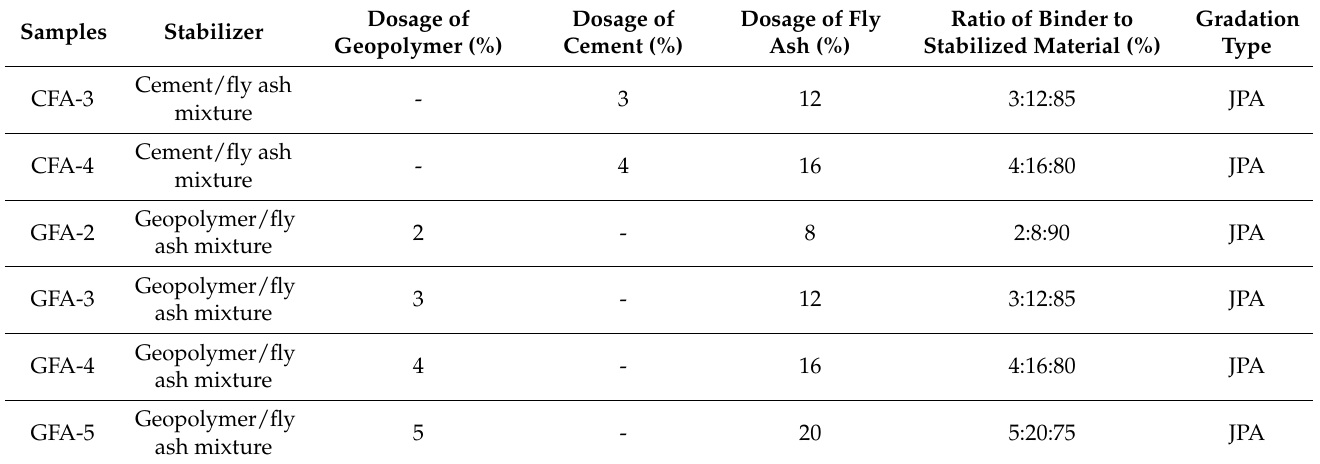
Table 3. The proportions of geopolymer-stabilized